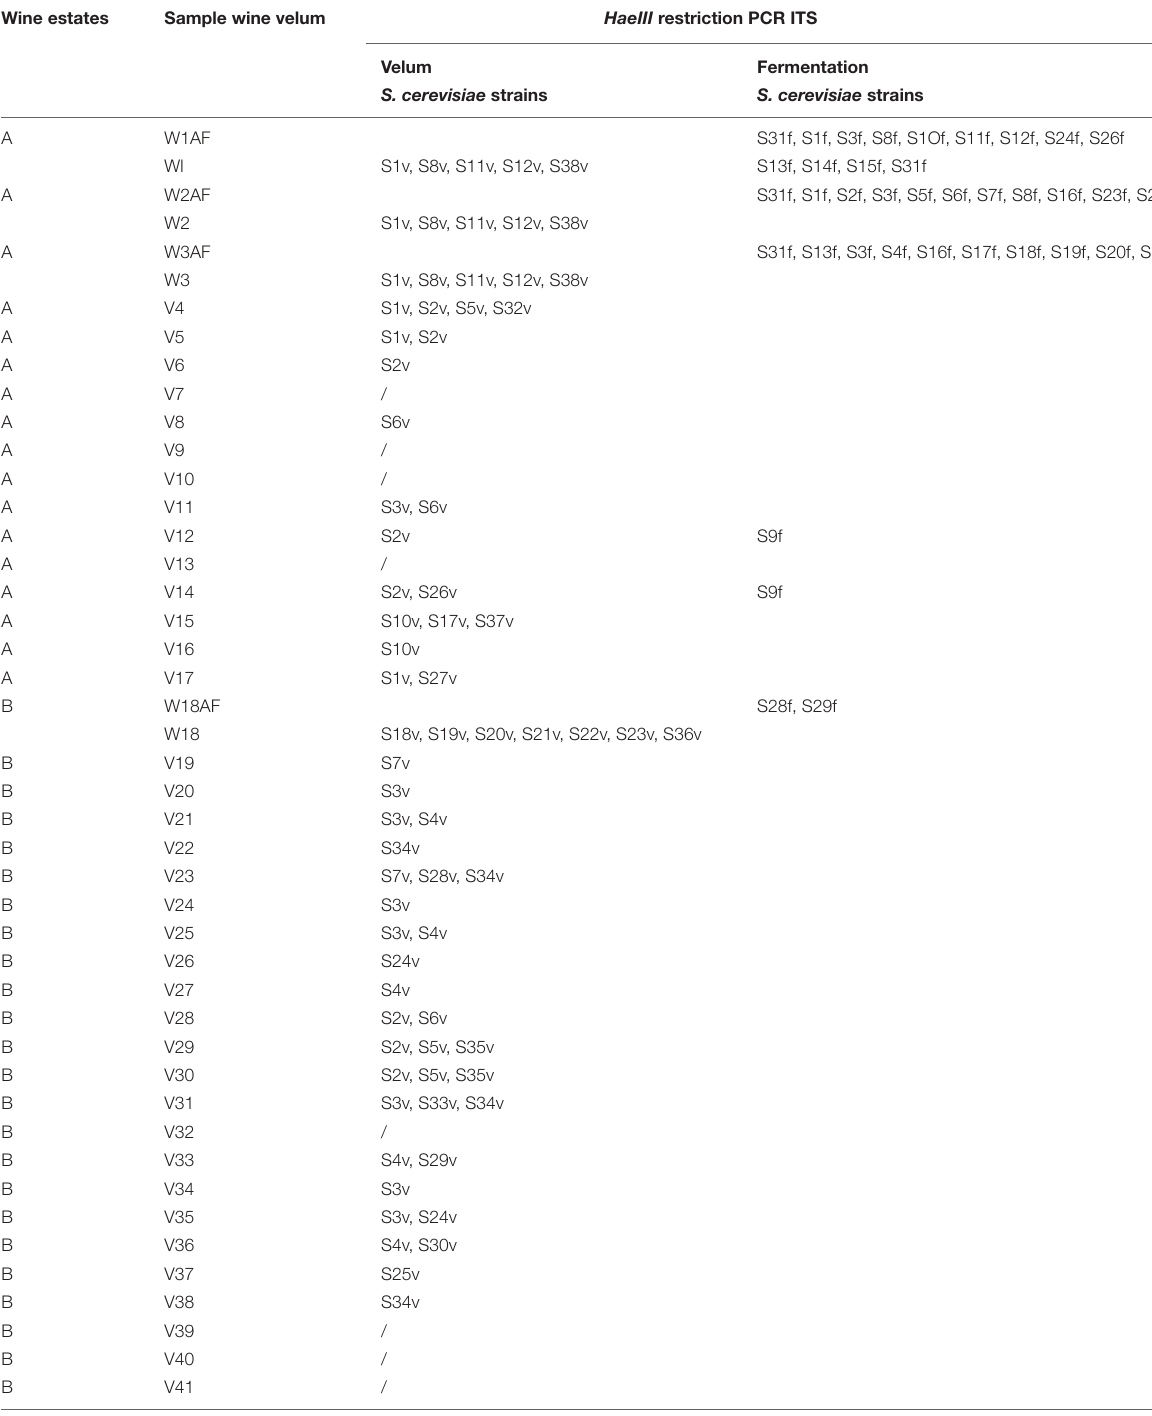
TABLE 2 | Identification of all the Saccharomyces cerevisiae strains isolated in all the velum according to their ITS RFLP profile. Wine estates Sample wine